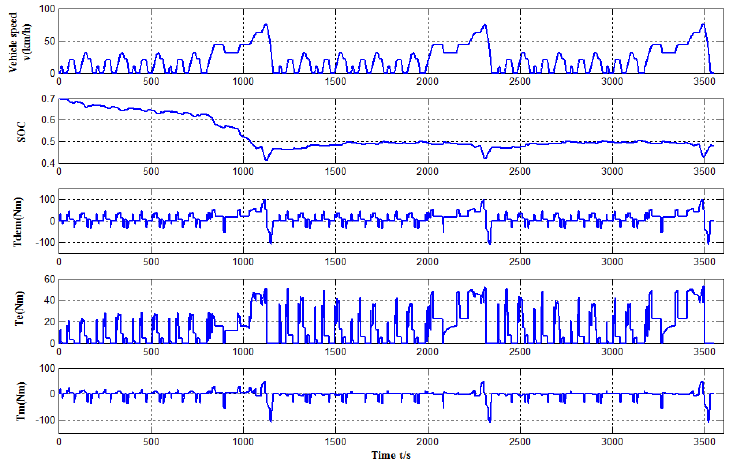
Figure 14. Simulation results under